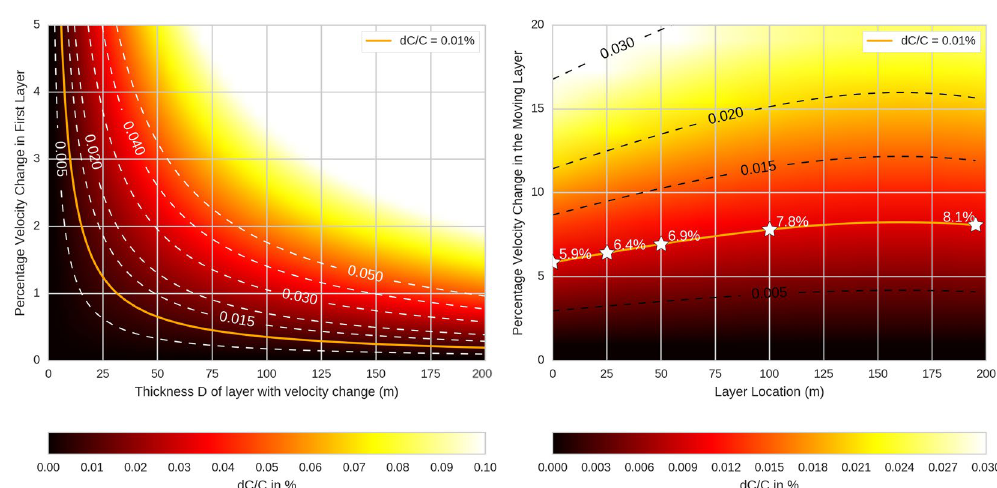
Figure 4. Modeled change dC/C (colour code) created by a change in velocity (y-axis) in: Left: a layer extending from the surface down to a depth D (x axis) or Right: a 5 meter-thick layer located at different depths. The reference model is based on Krüger 32 . The white or black dashed lines show chosen dC/C isolines (in %) and the orange line indicates dC/C at + 0.01%. The white stars on the right plot indicate example values of required P-wave velocity changes to induce an observed + 0.01% dC/C